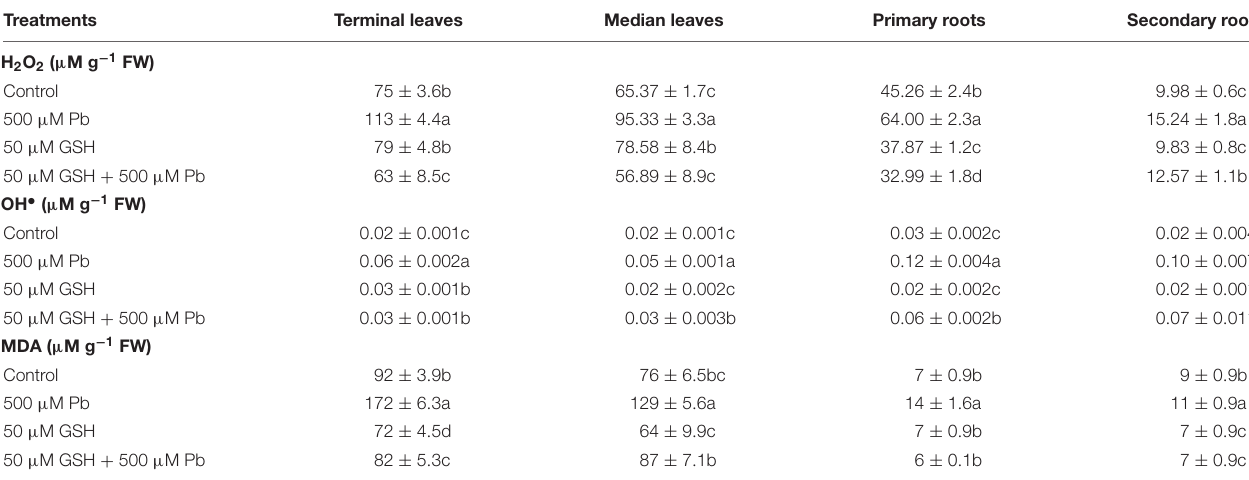
TABLE 1 | Lead (Pb) and reduced glutathione (GSH) mediated hydrogen peroxide (H 2 O 2 ), hydroxyl ion (OH • ) and malondialdehyde (MDA) contents in upland cotton leaves and roots.